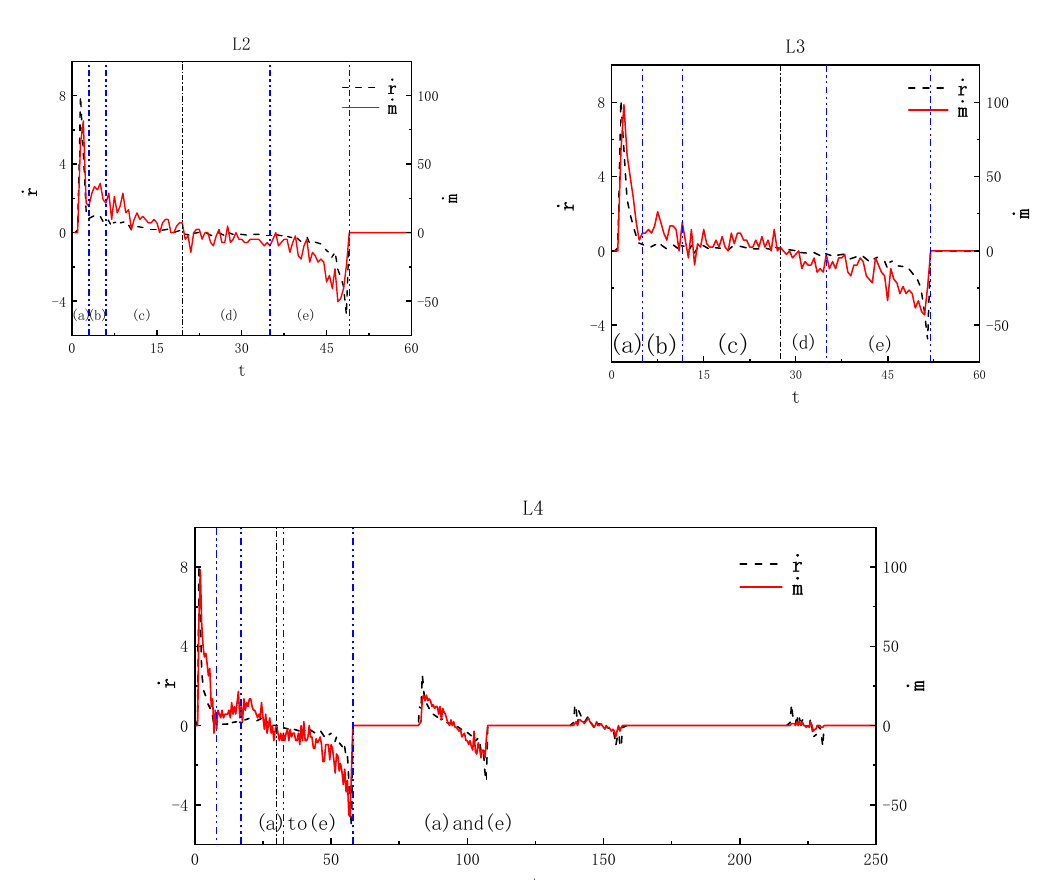
Figure 8. Average radius and vapor mass changing rates of the first bubble for Cases L2 to L4. The short dashed line is the time when the bubble reaches maximum volume. In each case, five bubble stages are identified: ( a ) inertial-controlled, ( b ) intermediate, ( c ) heat-diffusion-controlled, ( d ) precollapse, and ( e ) collapse.